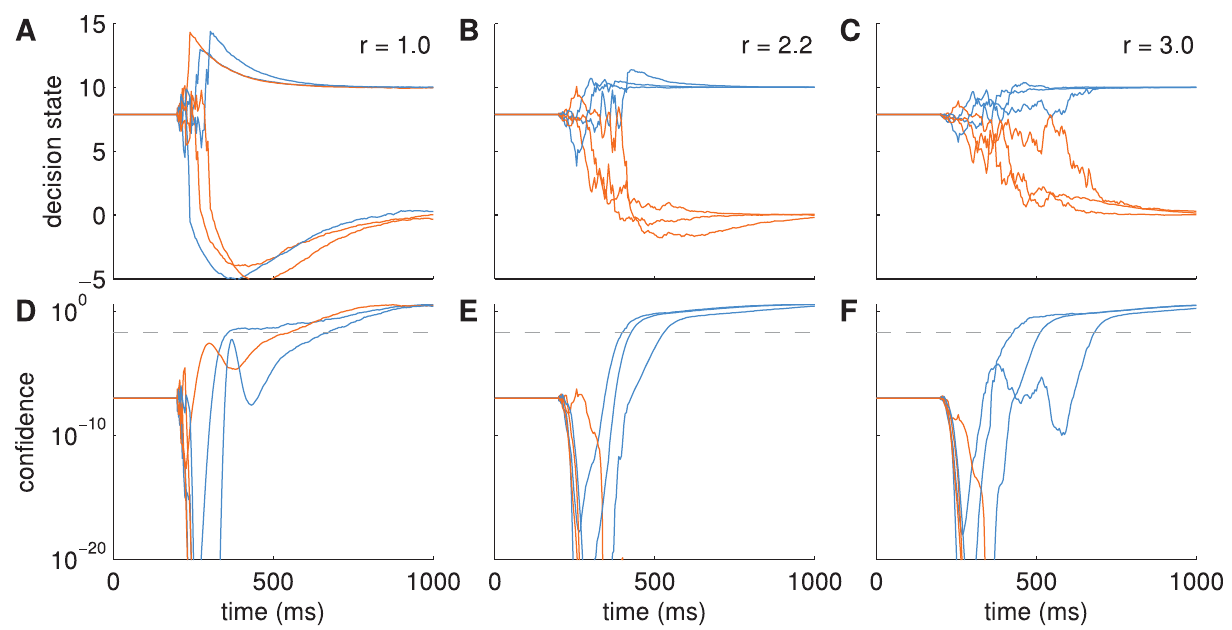
Fig 5. Example trajectories for the Bayesian attractor model on a binary decision task for varying sensory uncertainty r . Each of the plots shows three example trials. Note that there are two state variables (blue: alternative 1, orange: alternative 2) for each trial. (A-C) Decision state (cid:2) z . (D-F) Con fi dence (log-scale). Grey, dashed line: threshold used in the model. (A,D) r = 1, decisions are inaccurate and shoot over fi xed points (located at [10, 0] and [0, 10]). (B, E) r = 2.2, decisions are relatively fast and accurate, (C,F) r = 3.0, decisions are accurate but can be slow. The same sensory input with noise level (standard deviation) s = 4.7 was used in all three cases. Dynamics uncertainty was q = 0.1 and initial state uncertainty was p 0 = 5. Note that for clarity we plotted only the mean of the posterior distributions but not the posterior uncertainties (but see below for examples).